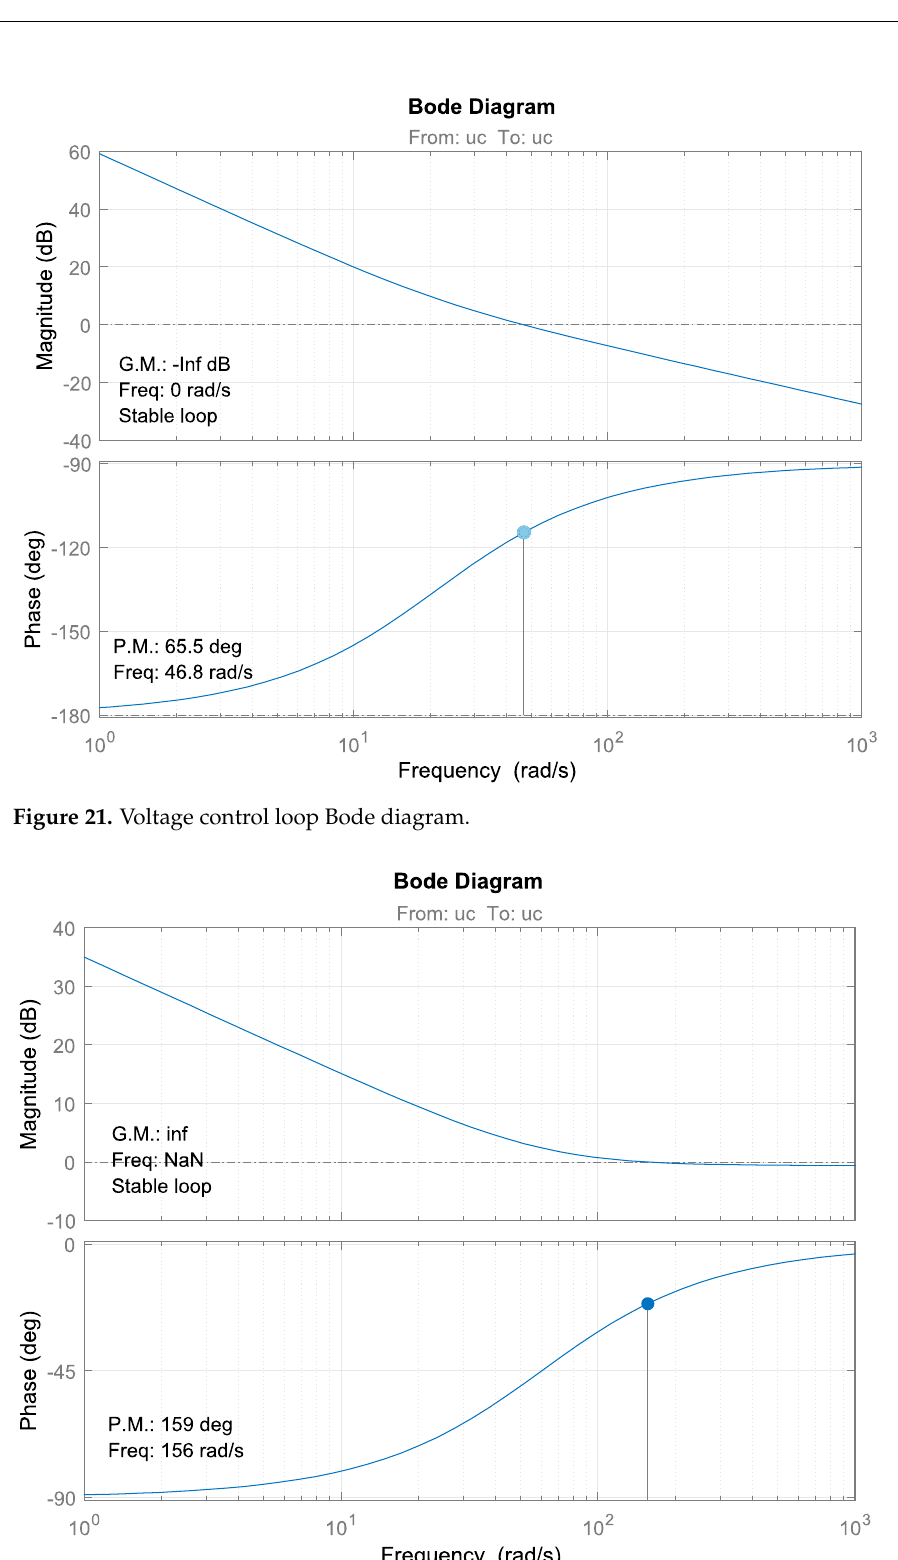
Figure 20. Current control loop Bode diagram.